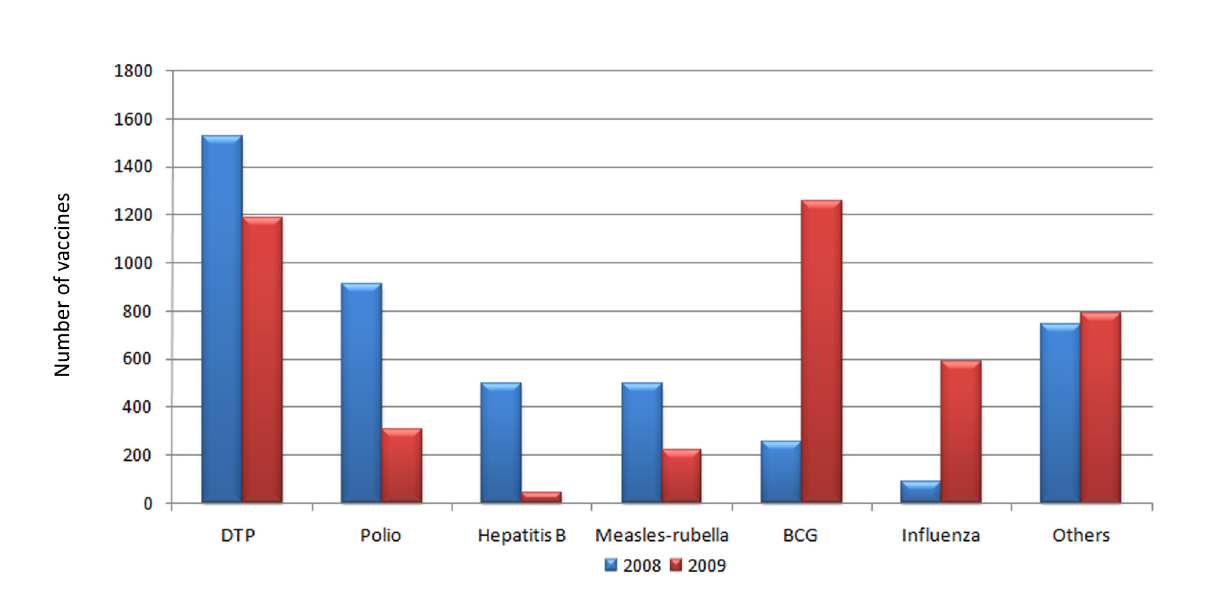
Figure 1. Types and amount of unused vaccines in 2008 and 2009 in Bauru